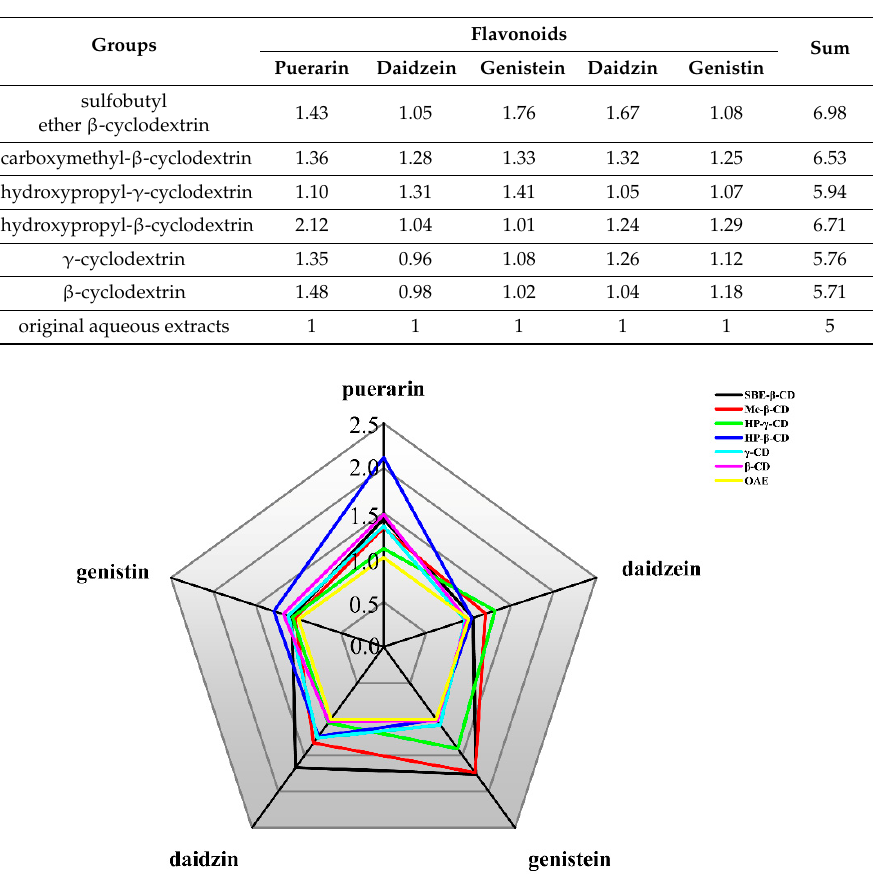
Table 3. Associated-extraction efficiency of different CDs (score).